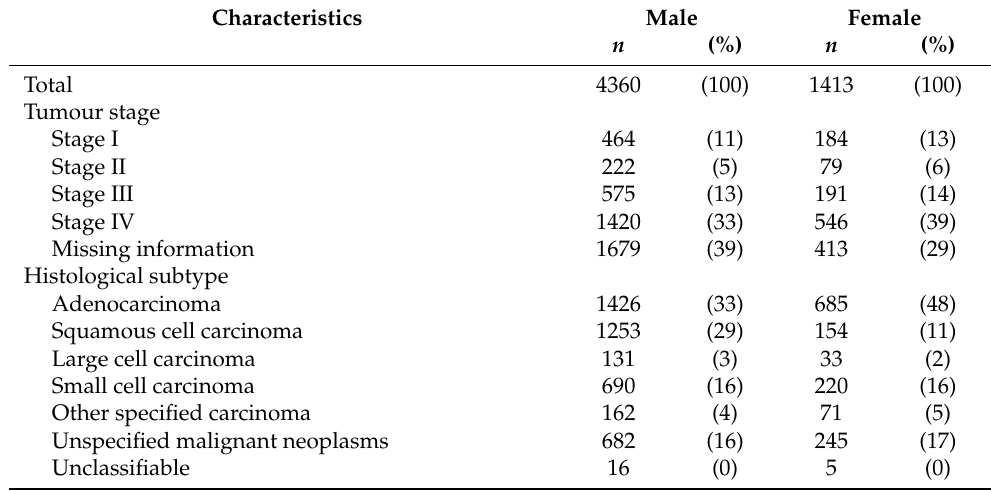
Table 2. Tumour characteristics: Incident lung cancer cases in French-speaking Switzerland